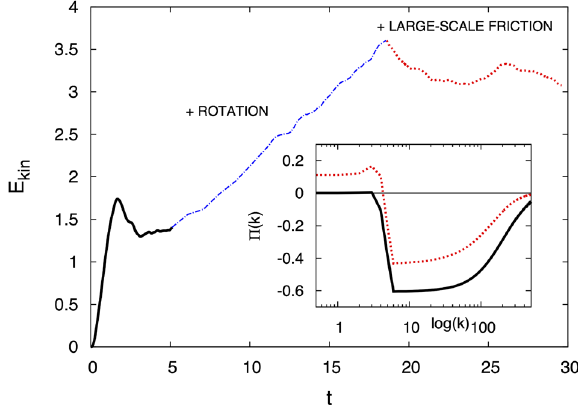
FIG. 3. Kinetic energy evolution for a typical run with large rotation rate, in the presence of an inverse energy cascade. We show the thermalization regime when rotation is not applied (black continuous line), the inverse cascade regime after rotation is switched on (blue dashed line), and the stationary regime obtained by the application of a large-scale friction (red dotted line). Inset: Kinetic energy flux measured at the two stationary regimes: without rotation (black continuous line) and with rotation and large-scale friction (red dashed line), in the DNS with large rotation rate Ω ¼ 10 .